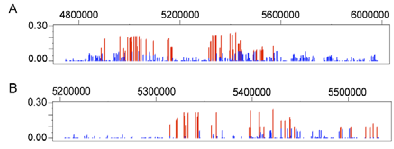
Figure 5. Genetic variation at HBE1 . LSBL plotted for (A) 50 kb and (B) 500 kb surrounding HBE1 . LSBL is shown on the X-axis and genomic position along chromosome 12 is shown on the Y-axis, with the axis labels located on the upper portion of the plots.